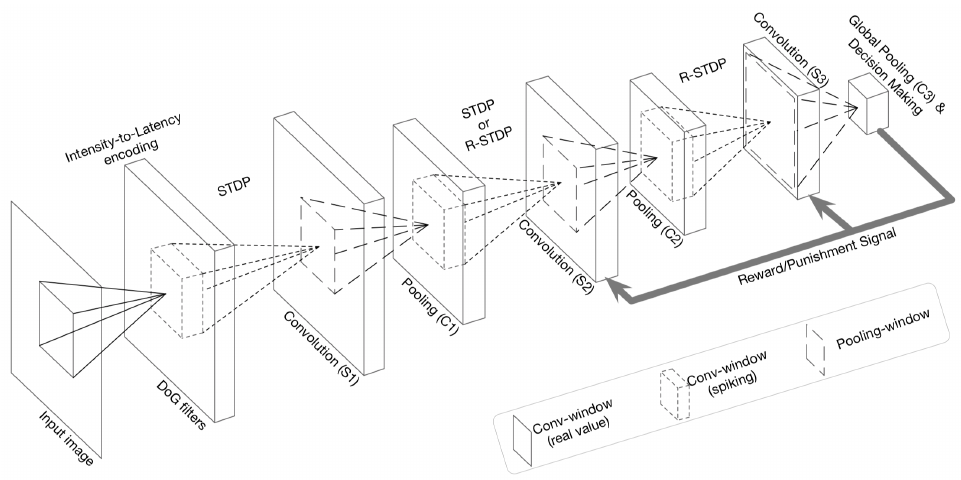
Figure 5. The overall structure of DCSNN for digit recognition. Courtesy of